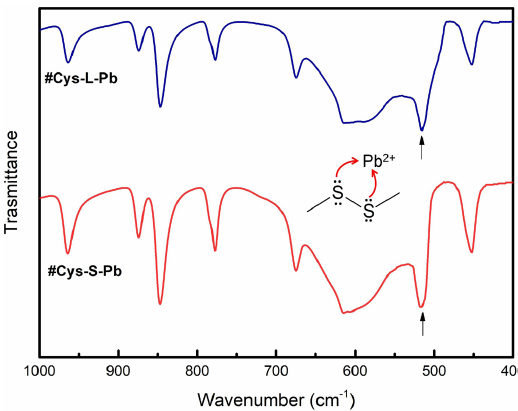
Figure 8. Kinetic data of Pb(II) adsorption by samples #Cys-L (a) and #Cys-S (b) fitted using pseudo-first-order (PFO) and pseudo- second-order (PSO) models. The results were obtained for initial Pb(II) concentration of 2.5 mg/L at pH 5.